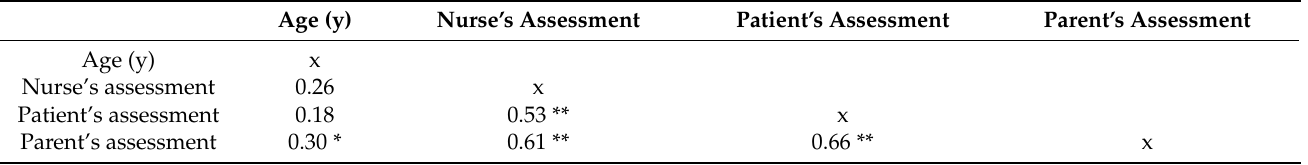
Table 4. Correlations between pain assessments for the various groups. Patients were ≥ 4 years of age. Age (y)